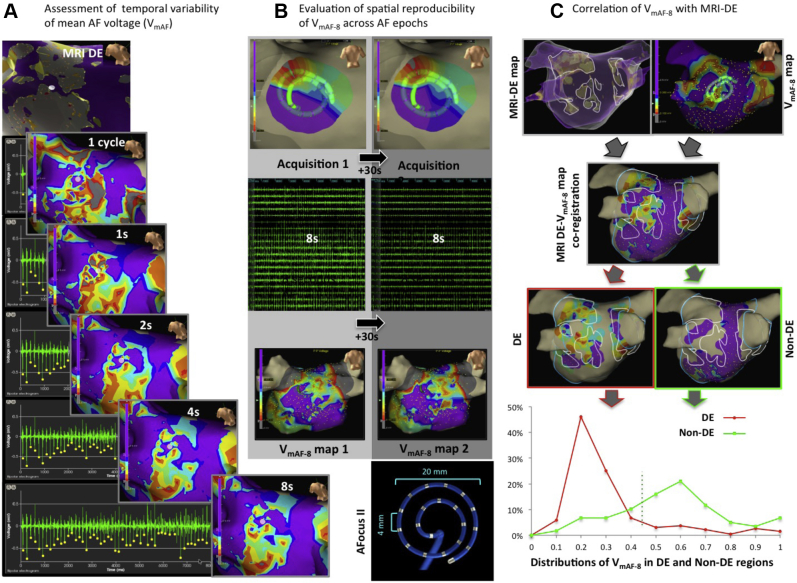
Data acquisition and analysis of mean atrial fibrillation (AF) voltage: temporal variability, spatial reproducibility, and correlation with delayed-enhancement magnetic resonance imaging (MRI-DE). A: Sampling adequacy AF electrograms imported into HEART. VmAF per electrogram is analyzed over varying sampling intervals (1 AFCL–8 seconds). VmAF maps demonstrate the spatial aspect of the temporal variability of VmAF compared to the MRI-DE model (top). B: Spatial reproducibility with the AFocusII held in a fixed position. Two separate acquisitions are used to generate 30-second time-shifted VmAF-8 maps. C: MRI-DE correlation. The VmAF-8 map is coregistered with the MRI-DE map. Markers are superimposed on the VmAF map delineating an MRI-DE threshold ≥2 SD MBP. VmAF points are subregioned into DE and non-DE, allowing for comparative histogram VmAF distributions. CL = cycle length.